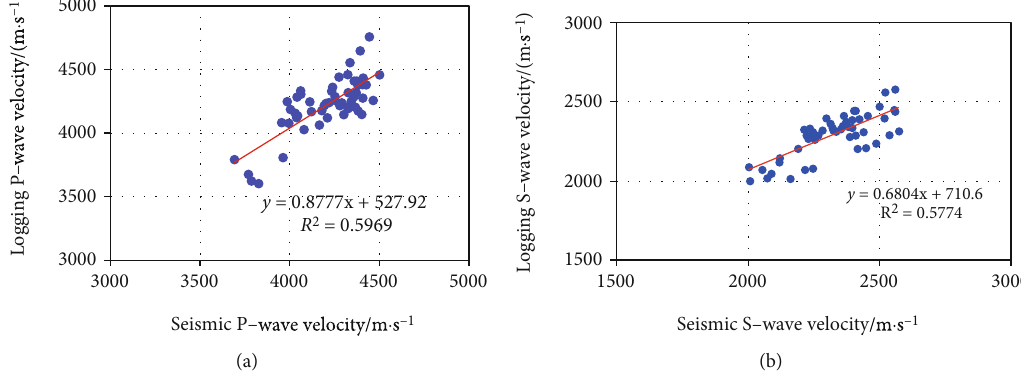
Figure 12: The relationships between the velocity obtained from well logging and that obtained from seismic inversion.